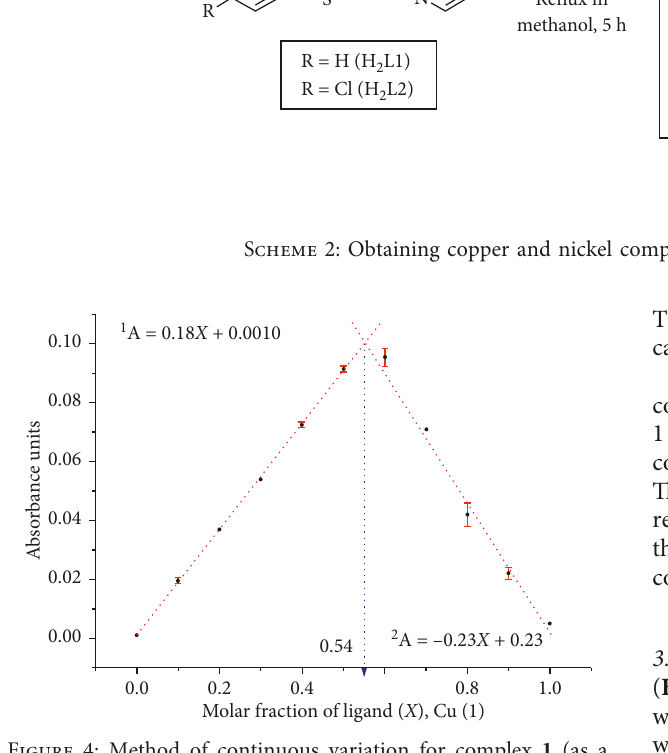
Figure 4: Method of continuous variation for complex 1 (as a representative example). In all cases, metals ions were allowed to react with TSC ligands for 15h before absorbance was measured at the maximum of the absorbance of the complex (Cu Ni 403nm). The assessment was performed with two in- (cid:31) dependent stock solutions.